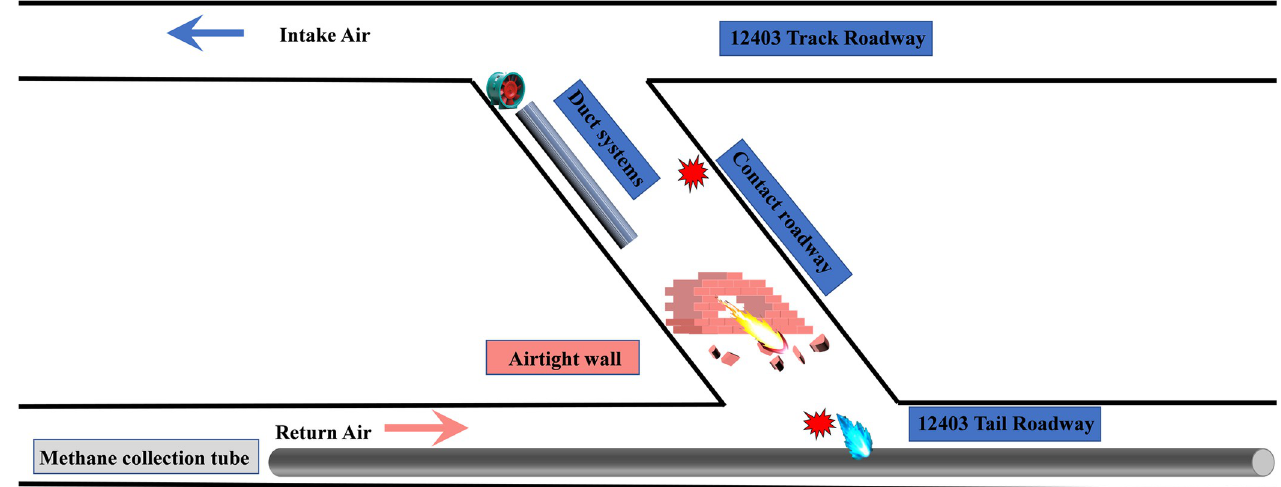
Fig 1. Schematic diagram of gas explosion location in Tunlan Coal Mine.